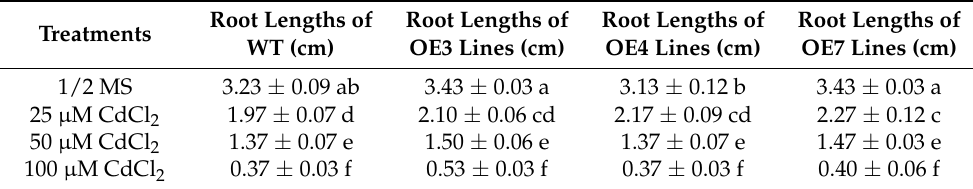
Table 1. Root lengths of 3 IlMT3 lines and WT under control and Cd treatments ( p < 0.05).